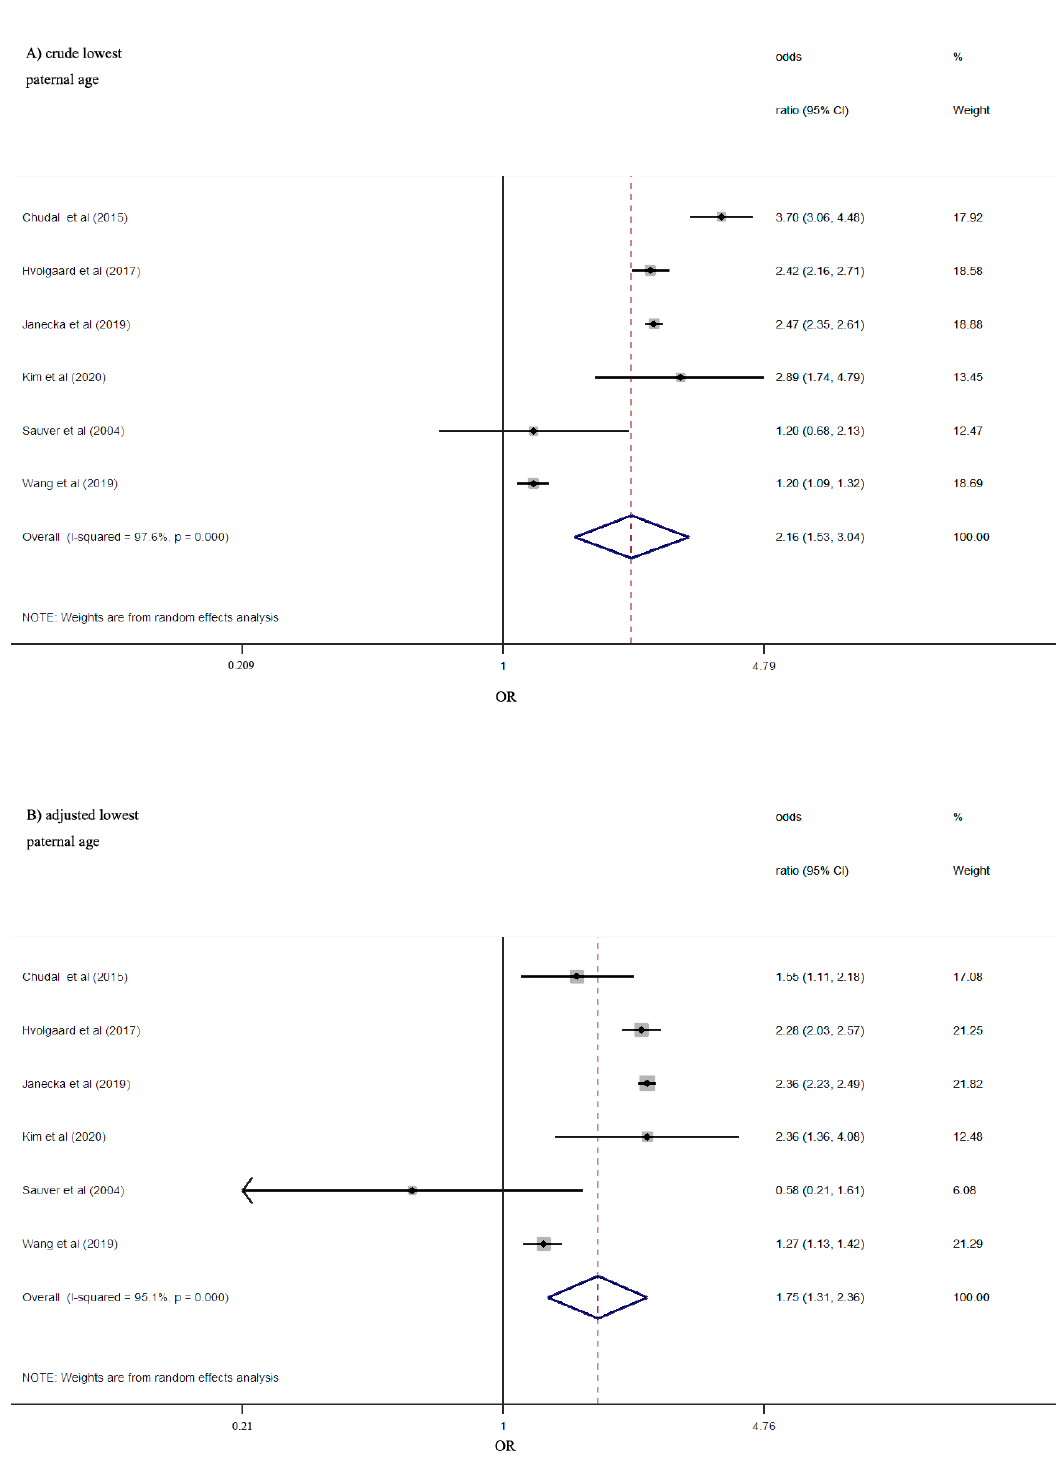
Figure 3. Risk of ADHD according to the lowest paternal age category vs. reference points. Pooled crude effects ( A ) and adjusted effects ( B ) for paternal age from random-effects meta-analyses are shown.